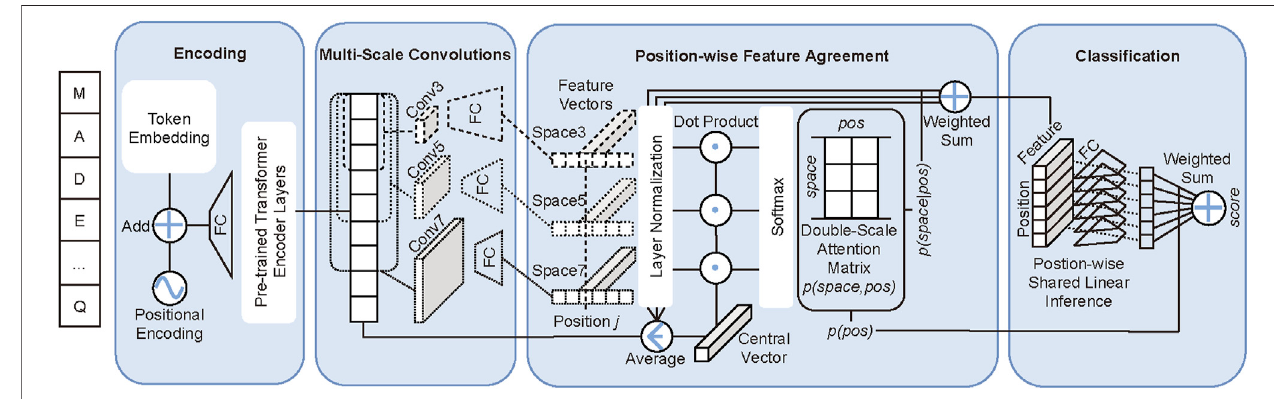
FIGURE1| DAttProtmodeloverview.Thesequence “ MADE ... Q ” isanexampleofinputproteinsequence.FCistheabbreviationofafullconnectionlayer.Conv k and Space k represent the k -kernel – sized convolution and the k -sized spatial scale. p ( pos ) is the weight vector on the positional scale and p ( space , pos ) is the weight matrix on both spatial and positional scales.